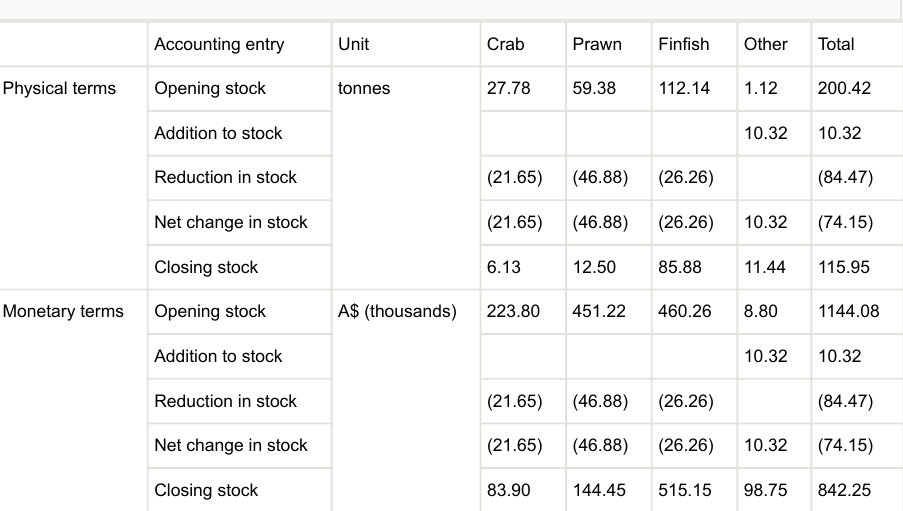
Change in landed catch from the fisheries sector (ANZIC 041) in Lake Illawarra between 2010 and 2020, in physical (tonnes) and monetary ($AUD)